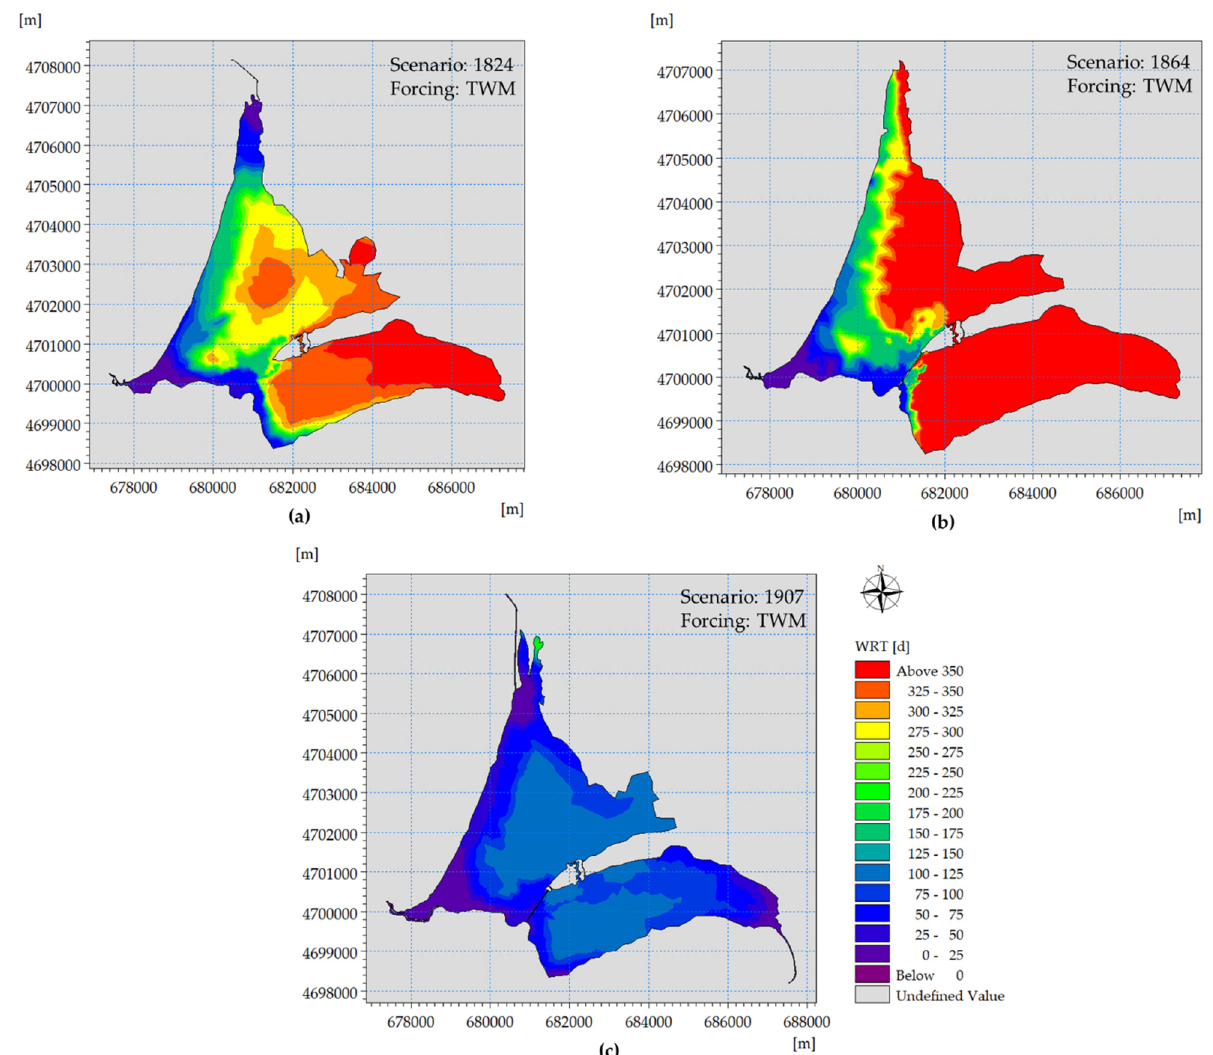
Figure 10. Distribution of WRT in Orbetello Lagoon in the reconstructed past scenarios: 1824 ( a ), 1864 ( b ), and 1907 ( c ). All cases are obtained under the full set of forcing mechanisms: astronomical tide, wind, and meteorological tide (code TWM).